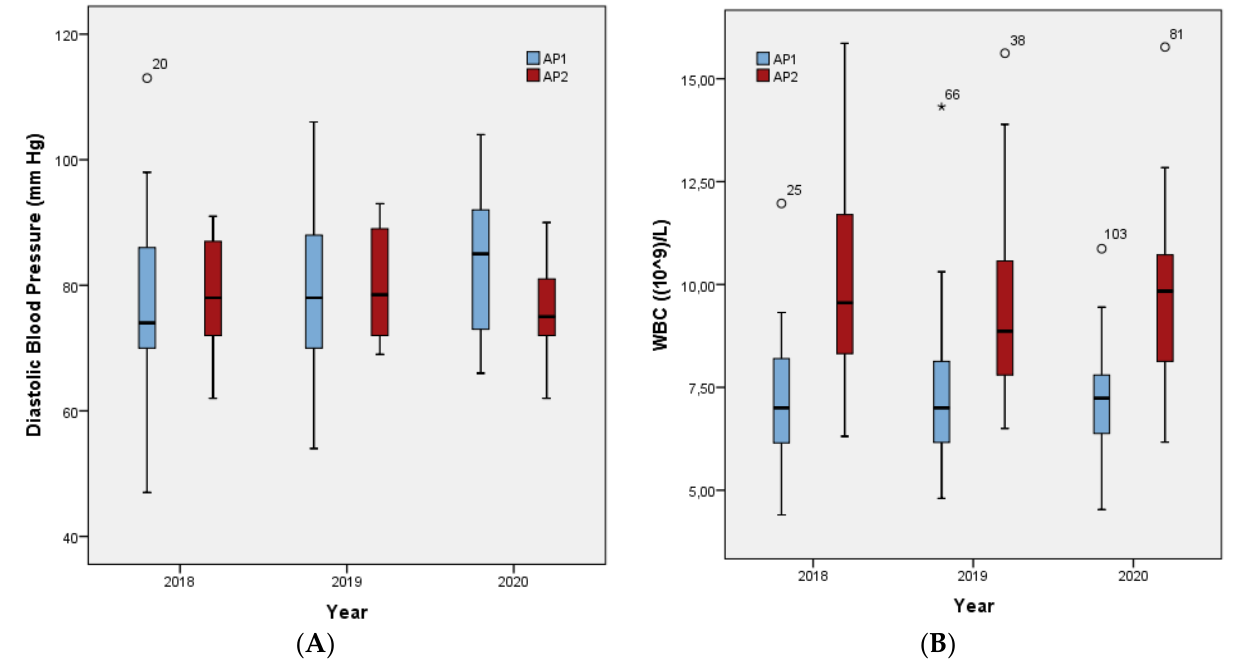
Figure 2. Box plots illustrating parameters that showed a significant difference in forensic psychiatric patients receiving AP1 and AP2, at the three yearly time points, 2018 (T1), 2019 (T2) and 2020 (T3). ( A ) diastolic blood pressure, ( B ) white blood cells (WBC). AP1, antipsychotics related to a low to moderate risk of WG, namely aripiprazole, amisulpride, quetiapine, risperidone, and ziprasidone; AP2, antipsychotics related to a higher risk of WG, namely paliperidone, olanzapine, asenapine, and clozapine.